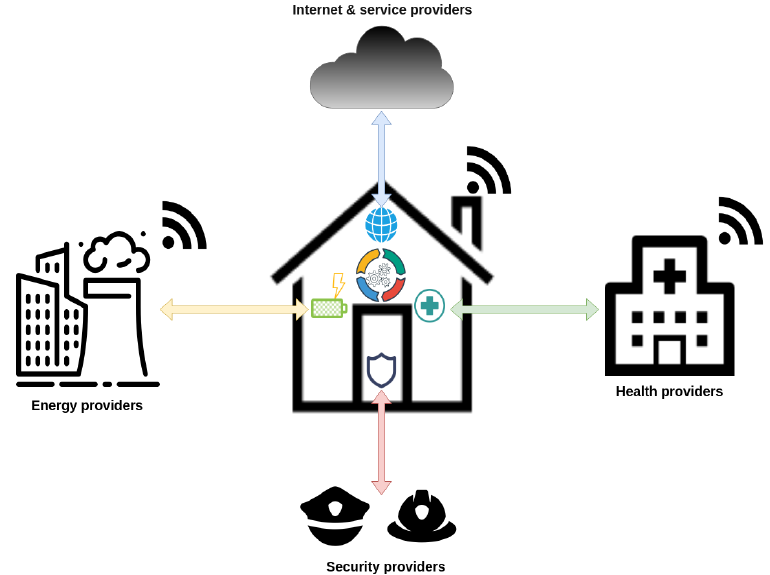
Figure 2. Interactions with external